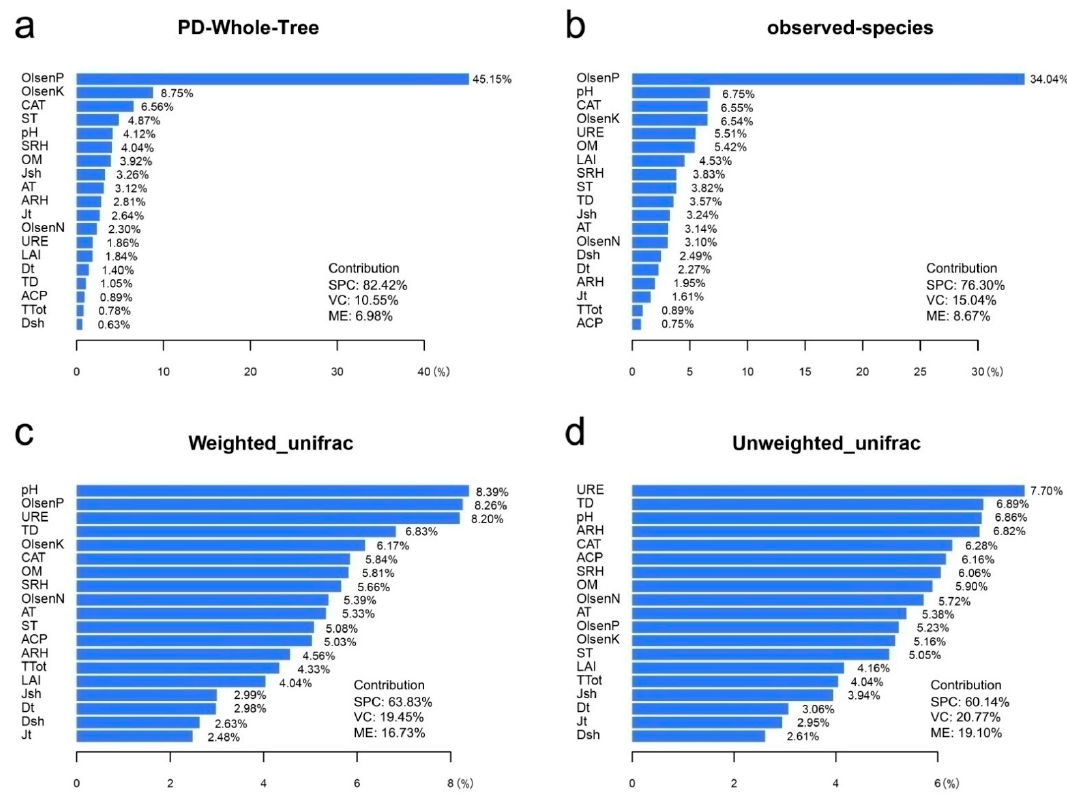
Figure 7. Relative influence ratios (%) of soil physicochemical properties, vegetation characteristics and microclimatic environment on airborne bacterial abundance and structure based on the ( a ) PD whole tree index, ( b ) observed-species index, ( c ) weighted UniFrac distance, and ( d ) unweighted UniFrac distance.